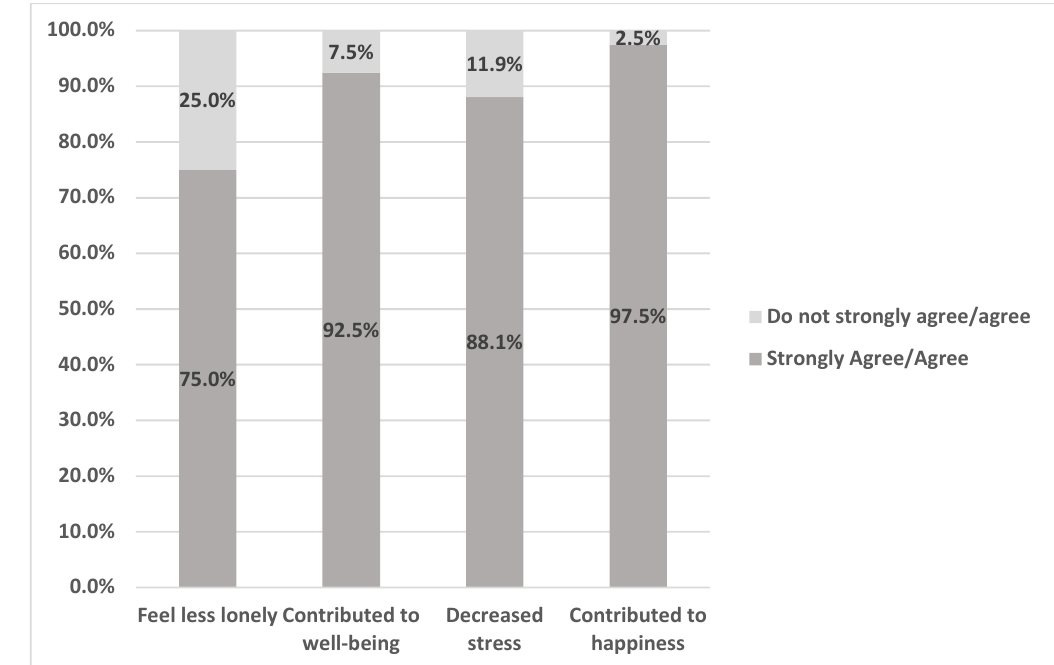
Figure 4. Web-based Survey Respondent Experiences with Sheepmowers.